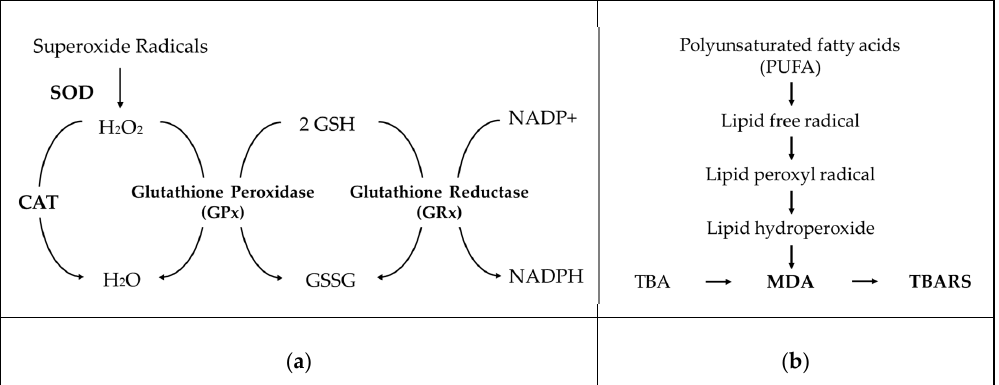
Figure 4. Glutathione oxidation pathway and lipid peroxidation pathway. ( a ) The glutathione pathway detoxifies superoxide radicals through the reduction of hydro-peroxides by glutathione peroxide (GPX). ( b ) Lipid peroxidation pathway is induced by ROS and MDA and TBRAS which are the products of the pathway used to assess the degree of the oxidation process.